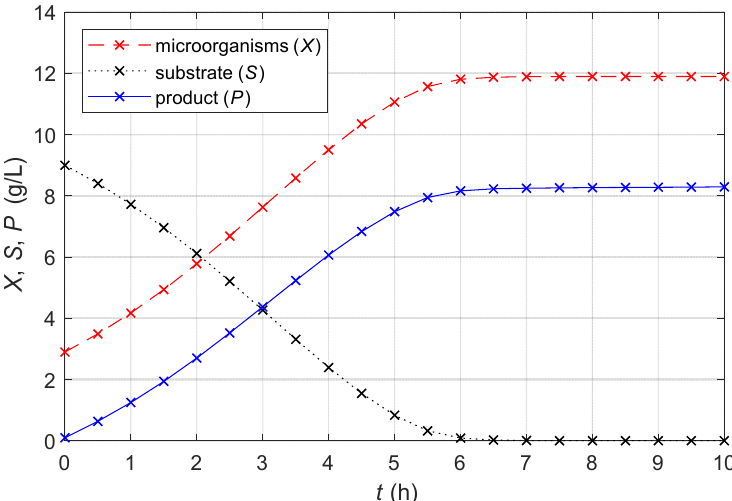
Figure 1. Time courses of concentrations of microorganisms, substrate, and product of analysed fermentation process in batch bioreactor with constant stirrer speed n = 80 min − 1 , obtained with a non-linear mathematical model (1)–(4) with the parameters in Table 1.